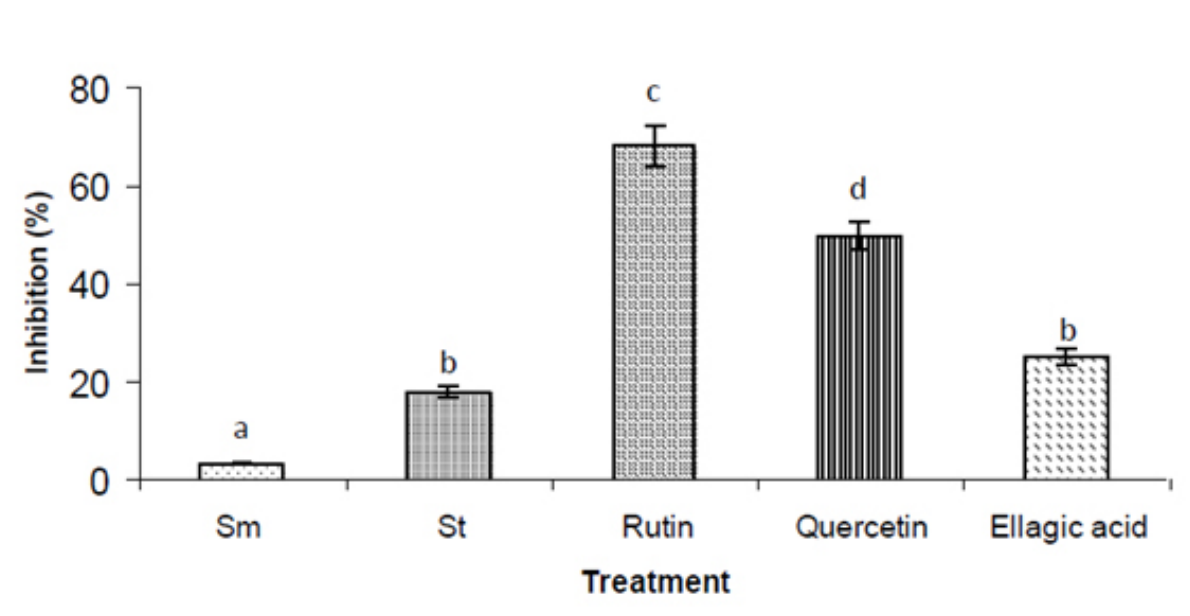
Figure 3. Inhibitory potential (%) of Spondias extracts and their flavonoids in DENV-2 (3.5 x 10 5 PFU) infected C . Sm: infected cells treated with 500 µg/mL of Spondias mombin ; St: infected cells treated with 6/36 500 µg/mL of Spondias tuberosa ; rutin: infected cells treated with 500 µg/mL of rutin; quercetin: infected cells treated with 500 µg/mL of quercetin; ellagic acid: infected cells treated with 500 µg/mL of ellagic acid; ANOVA and Tukey’s multiple comparison. Different letters indicate statistically significant differences at p <